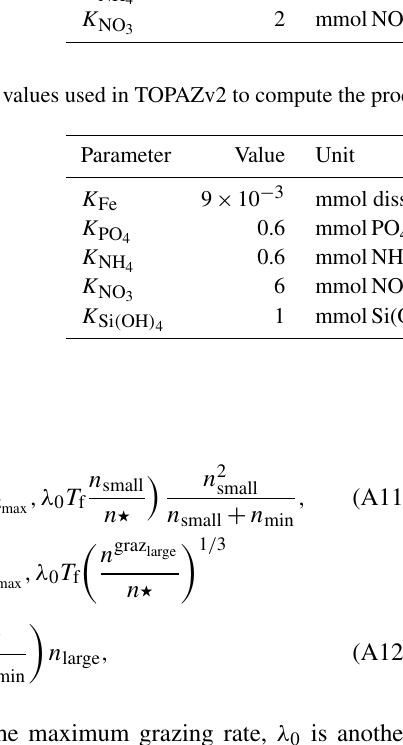
minimum phytoplankton concentration for grazing 0.01 d − 1 temperature-dependent response timescale for grazers Table A2. Parameter values used in TOPAZv2 to compute the production and grazing of small phytoplankton. Parameter Value Unit Name